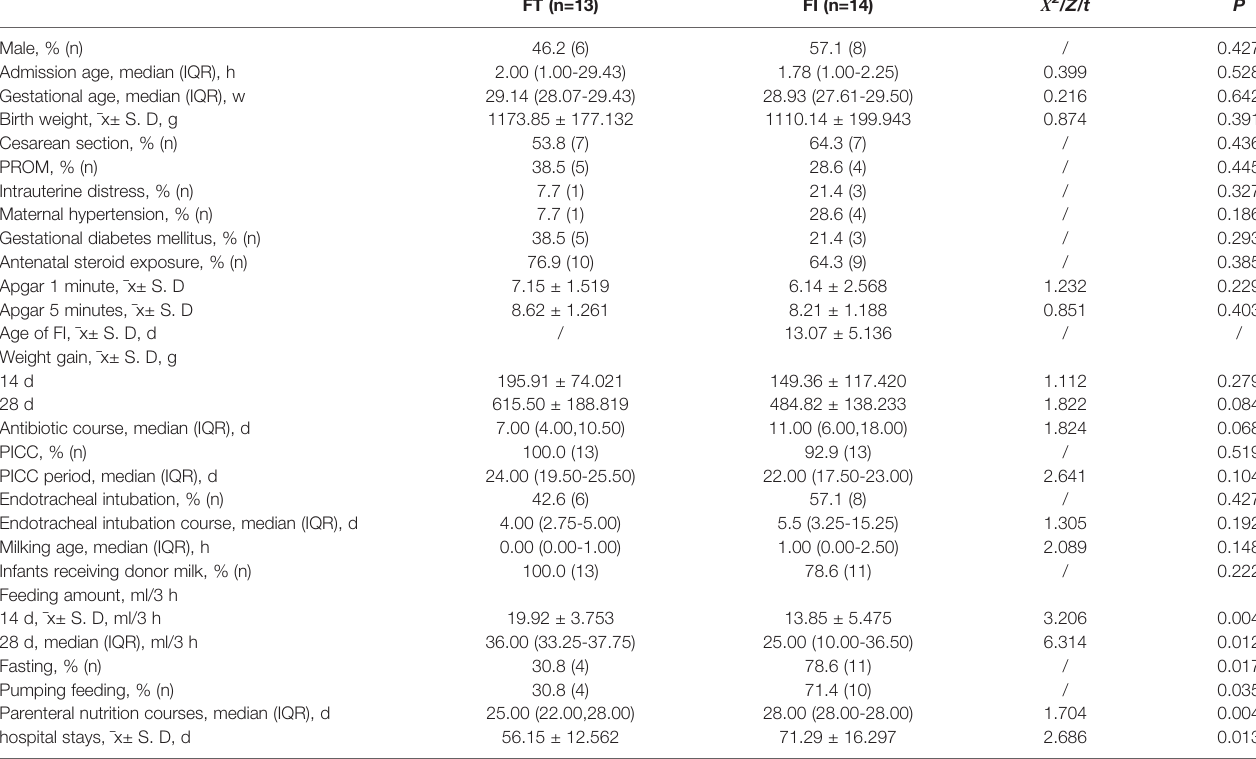
TABLE 1 | Clinical features of the infants enrolled in this